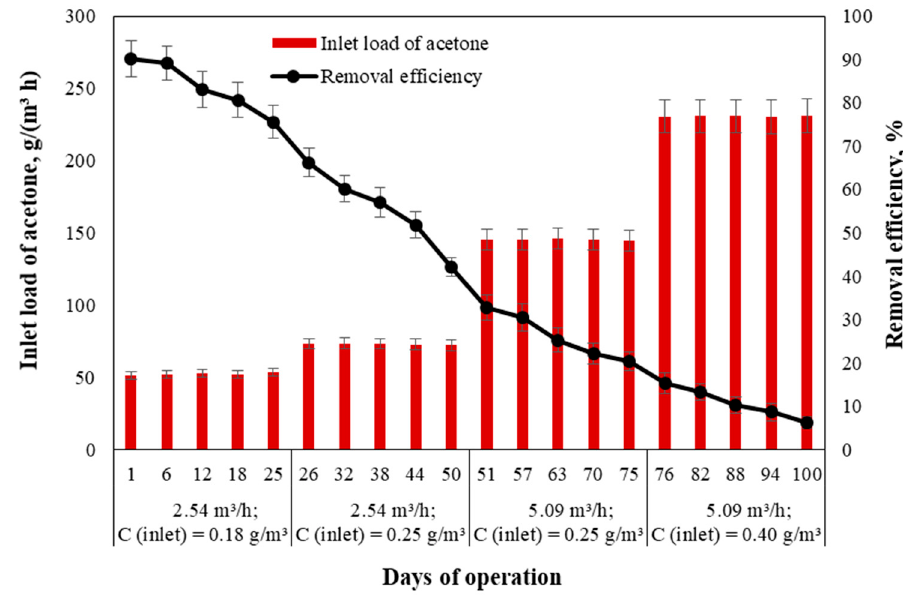
Figure 4. Influence of inlet acetone loading on the removal efficiency of the trickling filter.